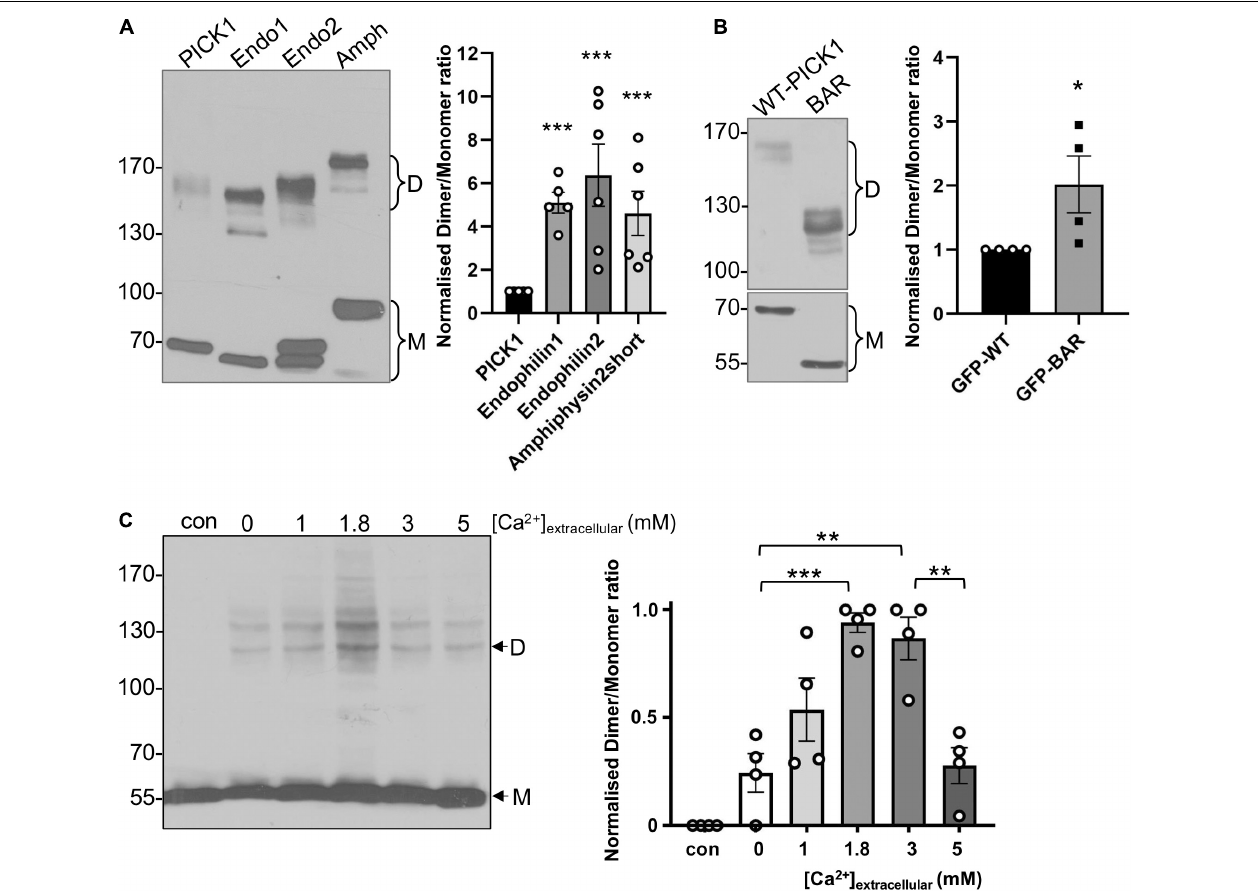
FIGURE 1 | PICK1 BAR domain dimerization is regulated by intramolecular interactions and by Ca 2 + in heterologous cells. (A) A smaller proportion of PICK1 is dimeric compared to endophilin and amphiphysin. HEK293 cells expressing GFP PICK1, GFP Endophilin A1 or A2, or GFP Amphiphysin were treated with 0.3 mM DSS. After quenching of DSS with Tris, the cells were lysed and proteins were detected by Western blotting using anti-GFP. Relative dimer to monomer band intensities were calculated. N = 6; *** p < 0.001. (B) The isolated BAR domain dimerizes more efficiently than full-length PICK1. HEK293 cells expressing GFP WT-PICK1 or GFP PICK1 BAR domain were treated with 0.3 mM DSS. After quenching of DSS with Tris, the cells were lysed and proteins were detected by Western blotting using anti-GFP. Relative dimer to monomer band intensities were calculated. N = 4; * p < 0.05. (C) HEK293 cells overexpressing untagged PICK1 were incubated in a range of extracellular [Ca 2 + ] plus ionomycin for 5 min, followed by 0.3 mM DSS for 20 min. The cells were lysed and proteins were detected by Western blotting using anti-PICK1. Relative dimer to monomer band intensity ratios were calculated. N = 4; ** p < 0.01, *** p < 0.001; “con” is without